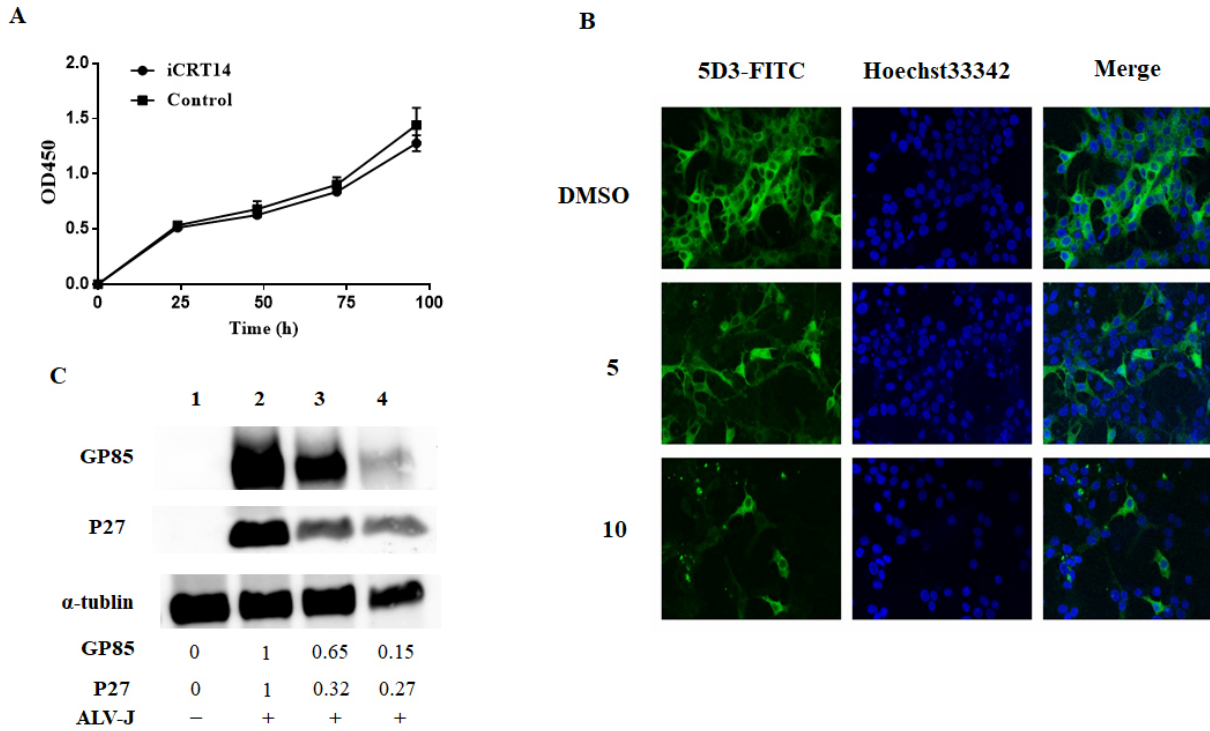
Figure 5. iCRT14 inhibited ALV-J replication in LMH cells. ( A ) LMH cells were treated with iCRT14 (10 μM) or vehicle control for various times (24, 48, 72, and 96 h), and the cell viability was detected by OD450 with CCK-8 kit. Data are expressed as the mean ± SD of three independent experiments. ( B ) LMH cells were infected with ALV-J in the presence of 5 or 10 μM of iCRT14 and DMSO. At 72 h p.i., the cells were fixed and stained for viral protein p27 (green) and the nuclei (blue). The pictures were captured and merged with a Leica SP2 confocal microscope (magnification, ×630). The results are representative of three independent experiments. ( C ) After 72 h p.i, the cell lysates were harvested for Western blotting. The control α-tubulin levels indicate that similar levels of protein were loaded into each lane, and the grayscale value of the bands in Western blot were analyzed with Image J software. Line 1: Nonvirus control group; line 2: DMSO group; line 3: 5 μM iCRT14 group; and line 4: 10 μM iCRT14 group. The immunoblotting experiments were performed independently at least three times with similar results. 3.3. Knockdown of β-Catenin Inhibits ALV-J Replication To further confirm the effects of the Wnt/β-catenin signaling pathway on ALV-J in- fection, we inhibited the pathway by knockdown of β-catenin using siRNA according to a previous report [19]. In our previous unpublished study, one siRNA 986 had interfer- ence capacity above 50% on β-catenin. Transfection of CEF cells with 986 siRNA resulted in a marked reduction of β-catenin gene and protein expression (Figure 6A,B). The inhi- bition of signaling pathway by knockdown of β-catenin significantly reduced gene and protein expression of gp85 and p27 (Figure 6A,C). Meanwhile, the virus proliferation was limited in CEF cells also (Figure 6D).